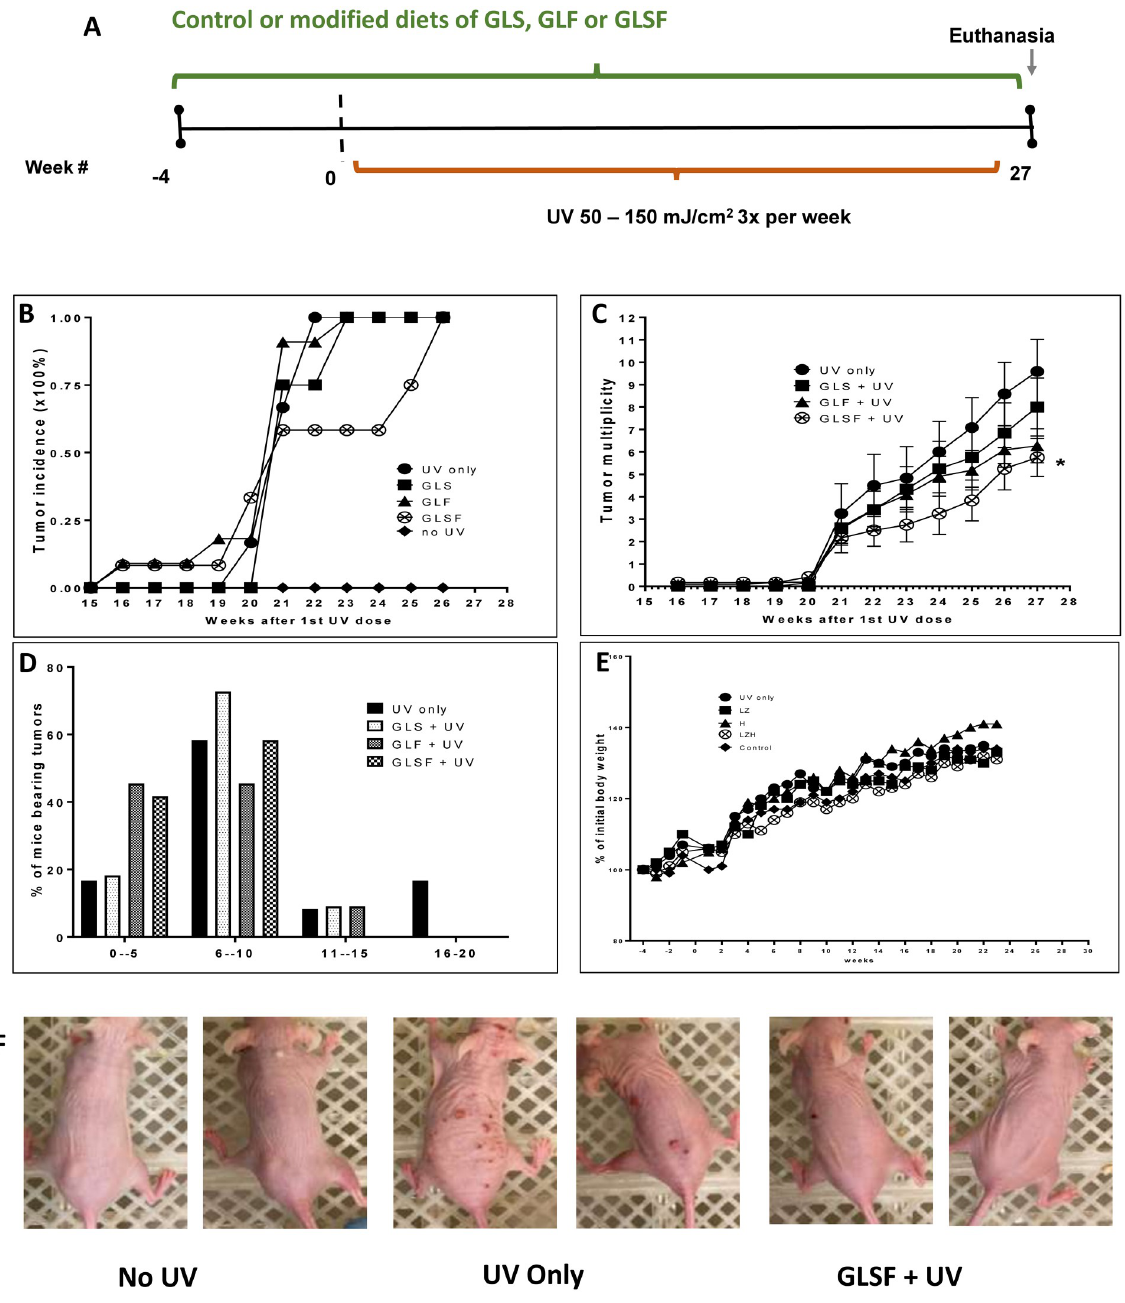
Fig 2. Effects of GLS, GLF and GLSF on development of skin tumor in SKH-1 hairless mice. (A) Experimental design. The mice were pre- treated with control diet or modified diets containing GLS, GLF or GLSF for 4 weeks before UV exposure was initiated. Then the mice were exposed to UV radiation of increasing doses three times per week for 27 weeks. (B) The percentage incidence of mice bearing tumors. (C) Tumor multiplicity (number of tumors per mouse). � : P < 0.05 as determined by t test. (D) Percentage of mice bearing tumors in each treatment group. (E) Average body weight in each treatment group (% of initial body weight). (F) Representative photograph of control mice without UV exposure, mice with UV only, and mice treated with GLSF and UV.